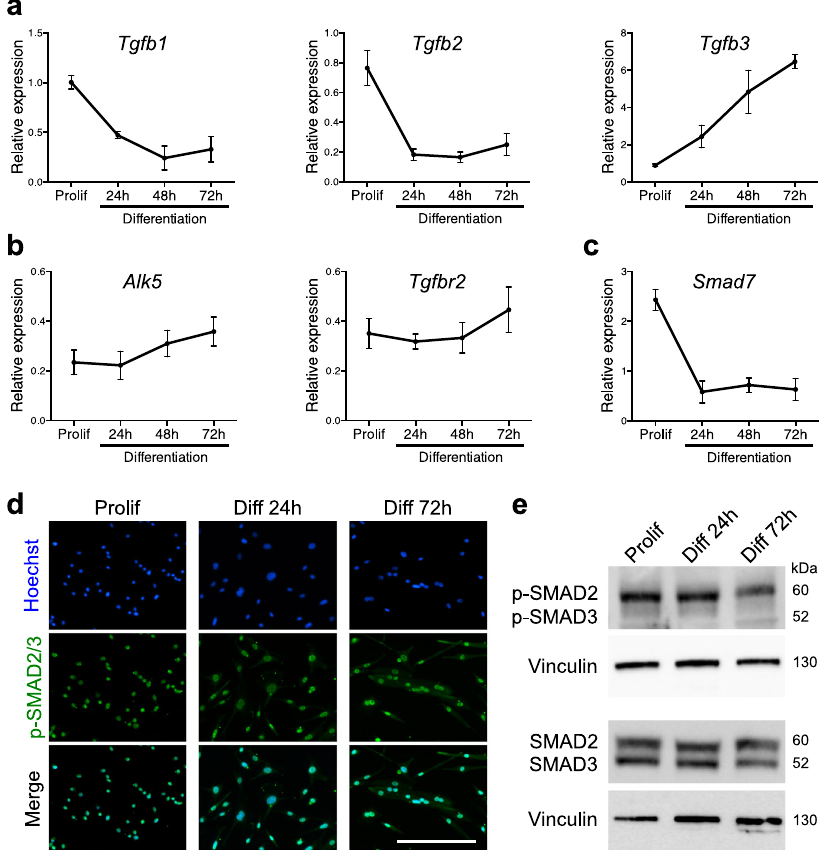
Fig. 1 TGF β signaling pathway remains active during myoblast differentiation. a qRT-PCR analysis of Tgfb1 , 2 , and 3 transcripts expression during in vitro differentiation of primary muscle cells shows different pro fi les. N = 3 biologically independent experiments for each time point. b qRT-PCR analysis of Alk5 and Tgfbr2 transcript expressions describes a constant expression of the receptors during primary muscle cell differentiation. N = 6 biologically independent experiments for each time point. c qRT-PCR analysis of the TGF β target gene Smad7 transcript expression reveals a decreased activity of the pathway alongside in vitro primary muscle cell differentiation. N = 3 biologically independent experiments for each time point. d